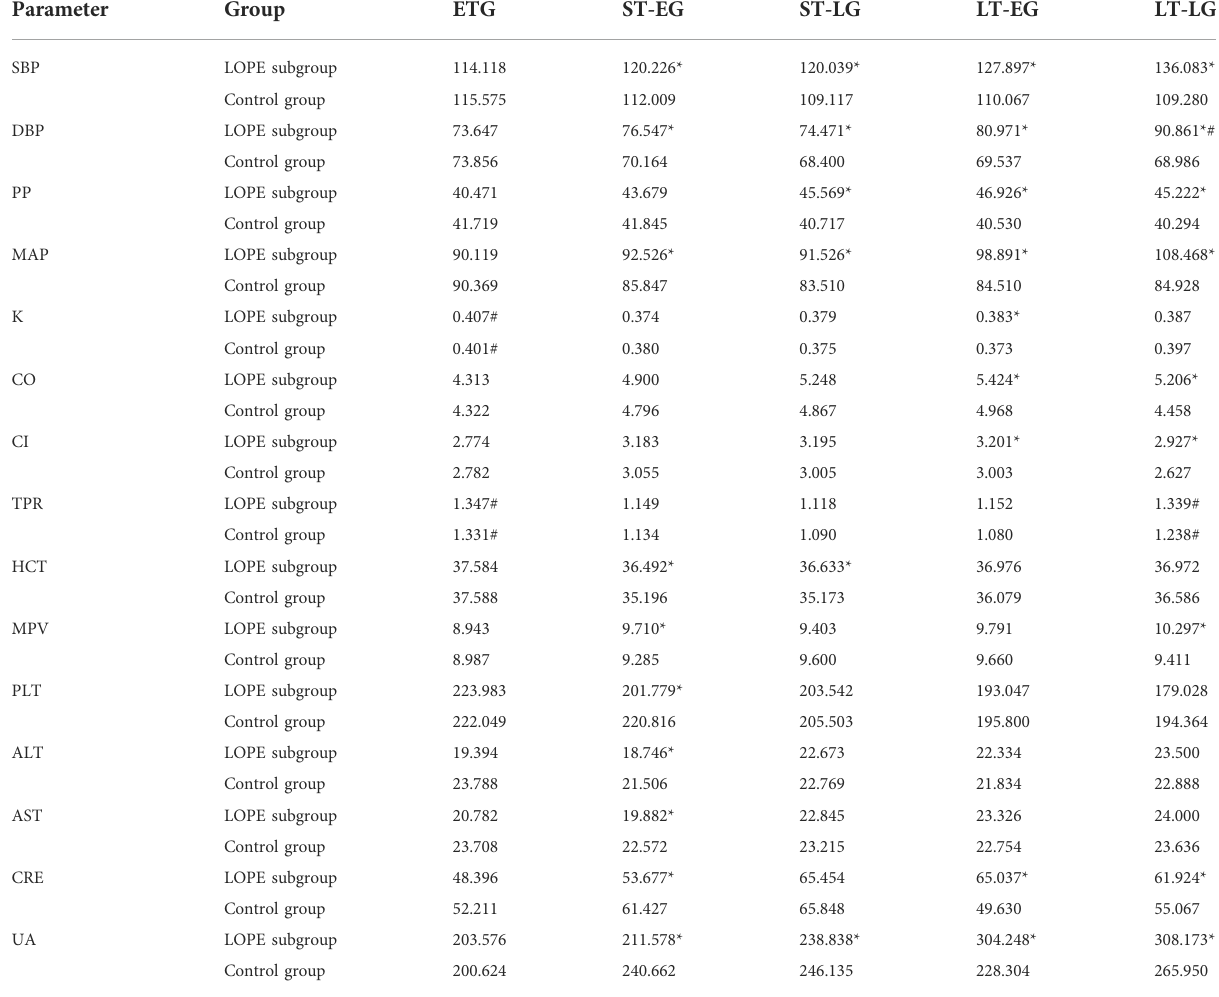
TABLE 5 Sensitivity analysis of H and B parameters in LOPE subgroup and control group.